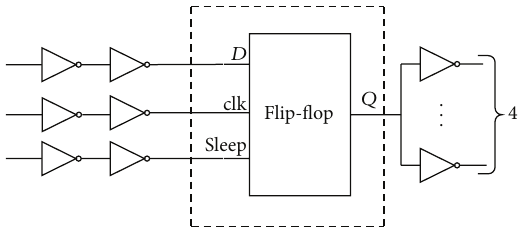
Figure 7: The test bench of the different data retention flip-flops.